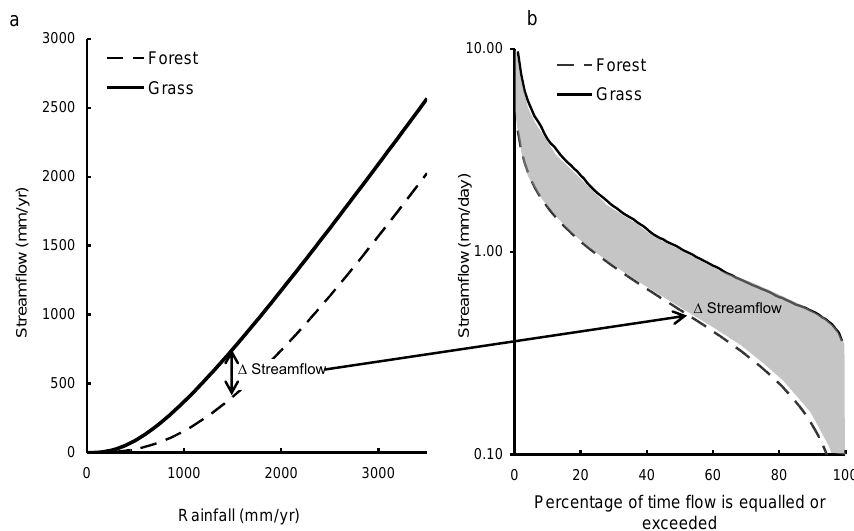
Fig. 2. Relationships between mean annual rainfall and streamflow for forested and grassed catchments as estimated by Zhang et al. (2001) (a) . The change in mean annual streamflow for a catchment from grass to forest is indicated by Δ streamflow. Flow duration curves (FDC) for a catchment under forest and grass covers (b). The shaded area between the FDC for grass and FDC for forest is equal to Δ streamflow.